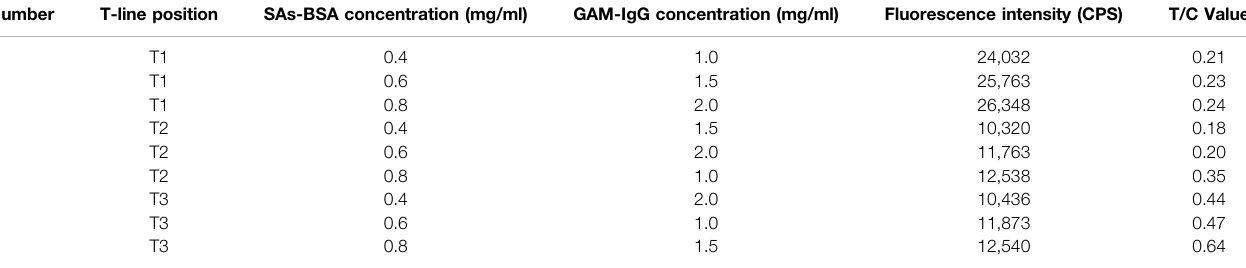
TABLE 1 | Orthogonal test to analyse the results of optimisation of L9 (3) 3 on SAs-BSA concentration, GAM-IgG concentration and paddle position.